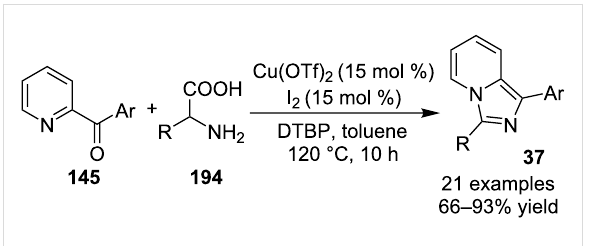
This strategy displayed high functional group tolerance at the aromatic ring of the enamides, however, aliphatic enamides phene ring in place of the benzene ring gave a product yield of only 27 and 44%, respectively. EW as well as EDGs present at methyl group present at o - and p -positions which did not result